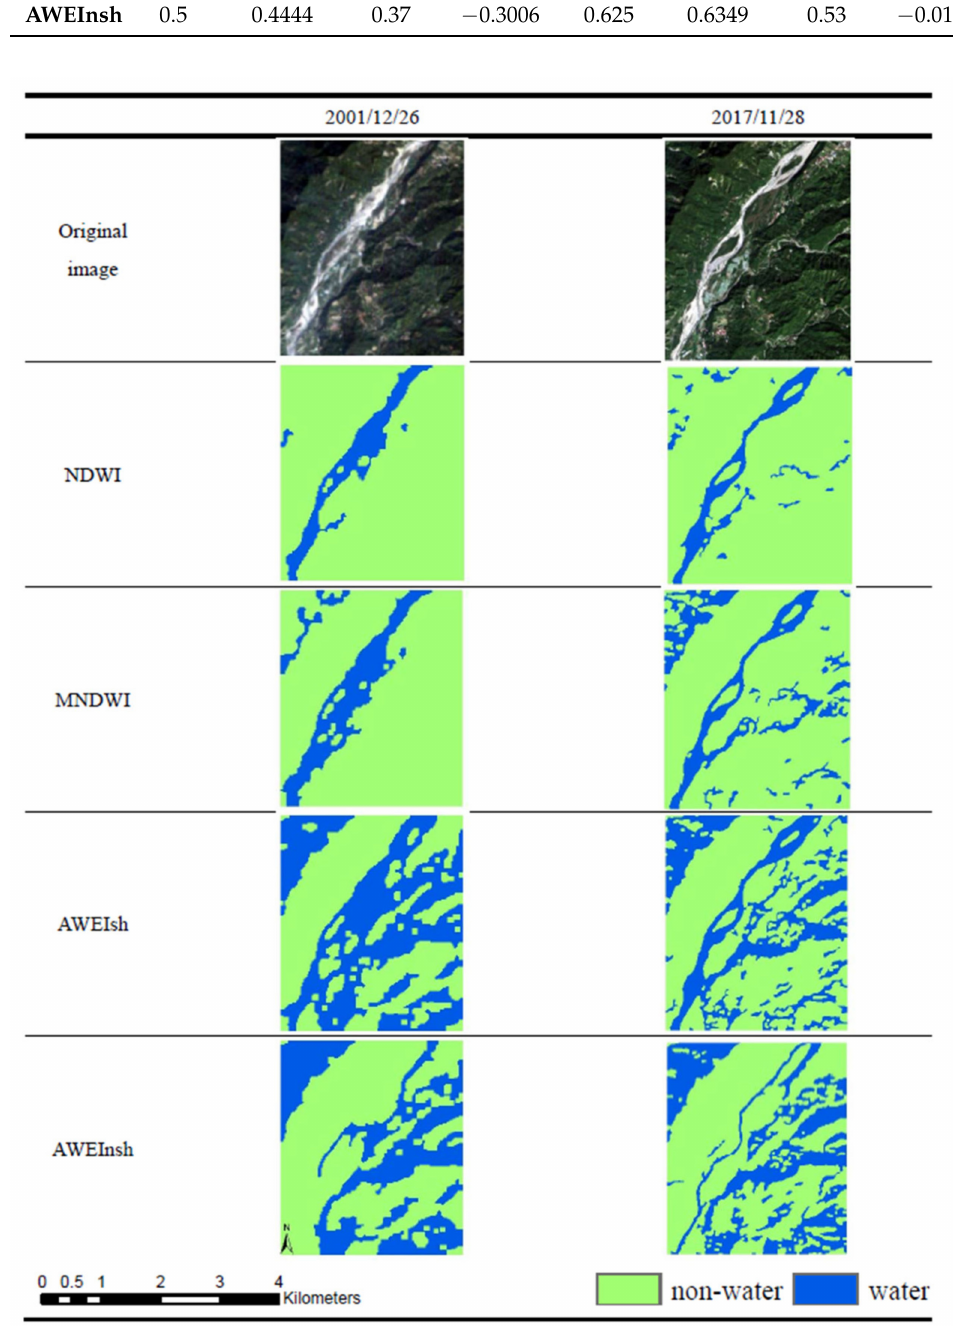
Figure 7. Qishan River: Results of spectral water body indices in terms of water body extraction on different